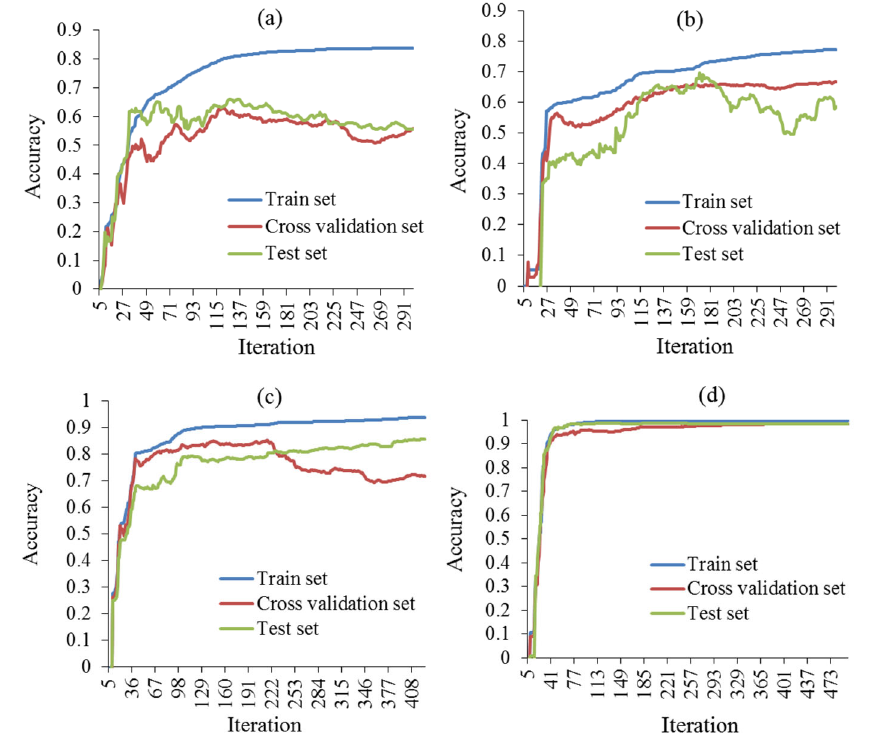
Figure 9. Learning curves of the neural network based on the best ‐ combined variables through training, cross ‐ validation, and testing using a different number of iterations: ( a ) 14VI, ( b ) 5GLCMF, ( c ) 2T, ( d ) VI ‐ GLCM ‐ T ‐ 21.